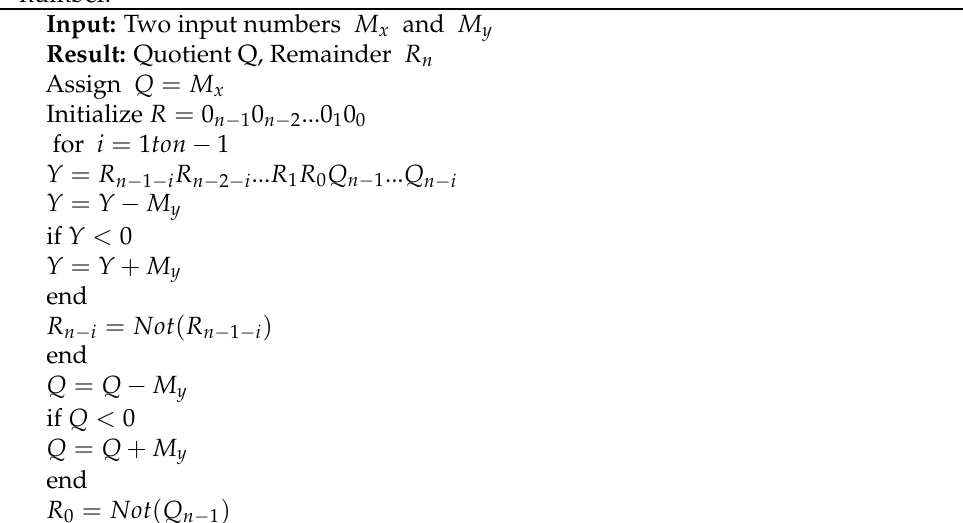
Algorithm 2: Restoring division algorithm for mantissa of the floating-point